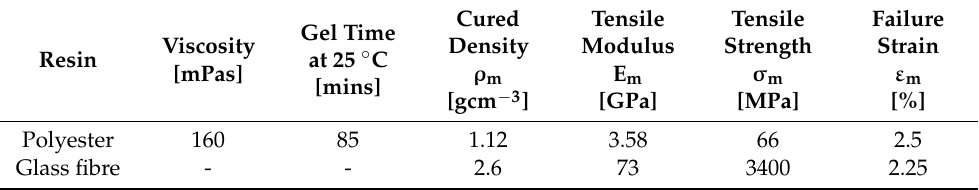
Table 1. Physical and mechanical properties of polyester matrix (from supplier datasheets).